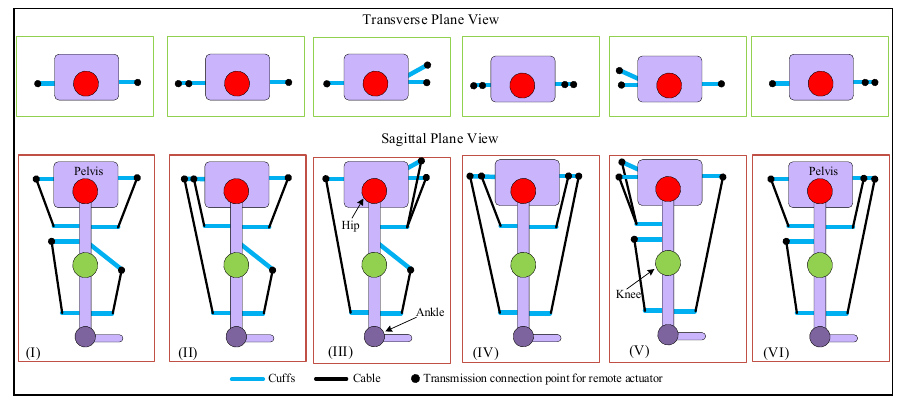
Figure 4. Possible routings for 4-cable driven C-LREX constraining 2 cables for the knee joint (transverse and sagittal planes view).